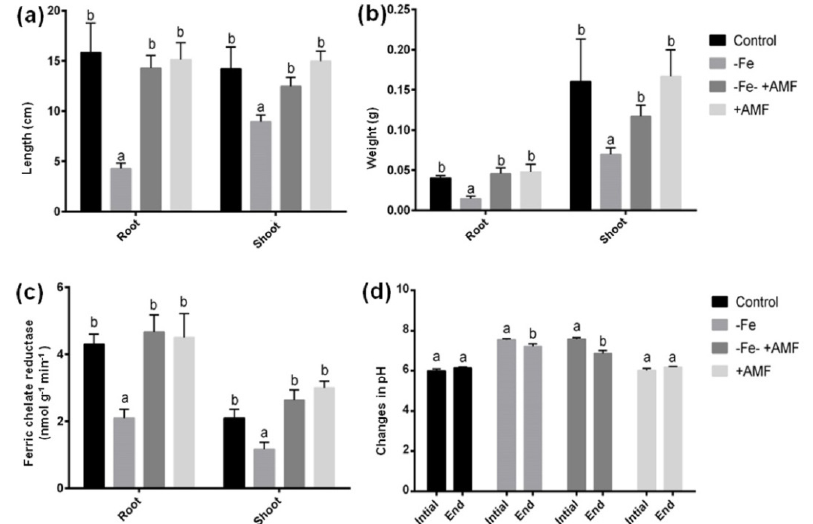
Figure 2. Effects of Fe deficiency and AMF on morpho-physiological parameters in alfalfa. (a) Root-shoot length, (b) root-shoot biomass, (c) ferric chelate reductase activity, and (d) changes of solution pH under Fe deficiency with or without AMF. Data represent means ± SD ( n = 3). Different letters indicate significant difference at p < 0.05 level.